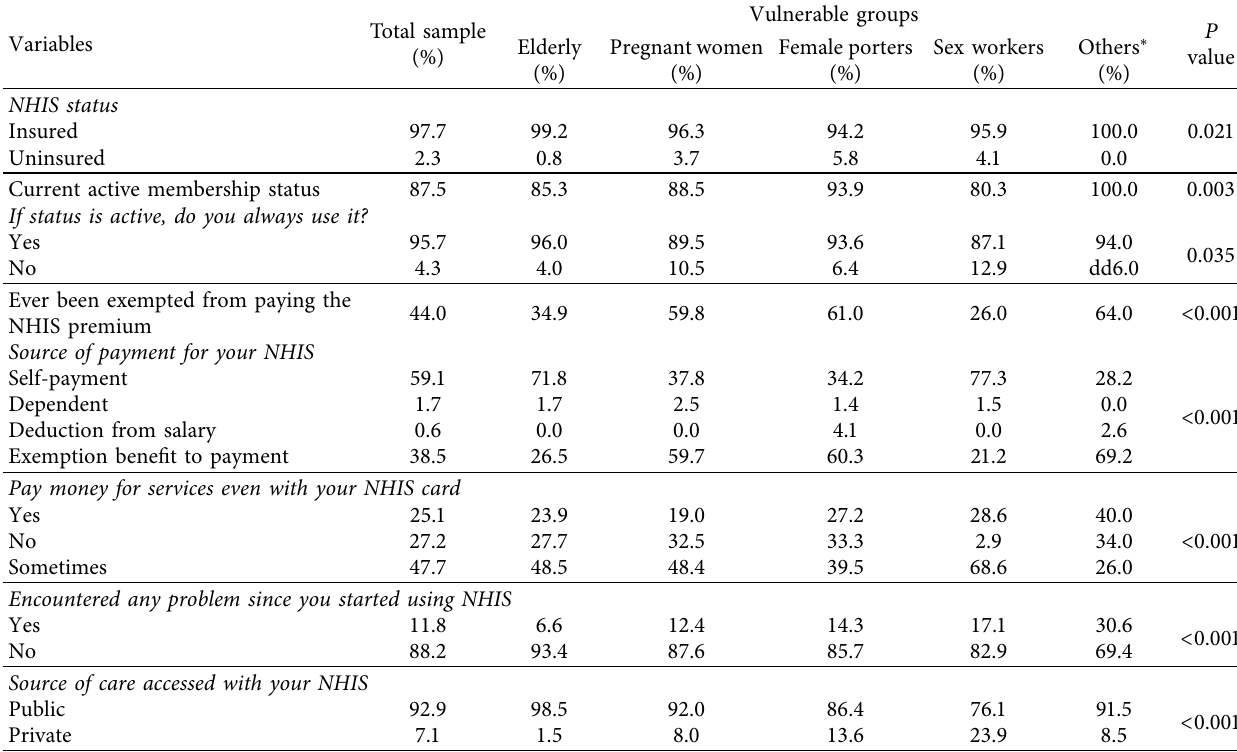
Table 4: Acceptability of health services under the NHIS.